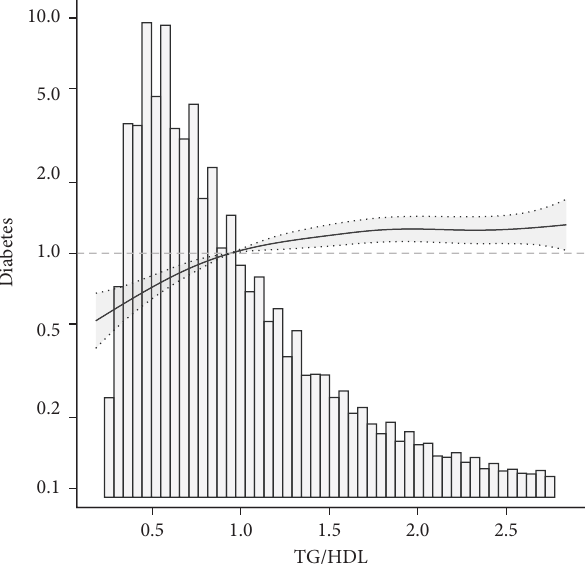
Figure 3: Association between TG/HDL and diabetes